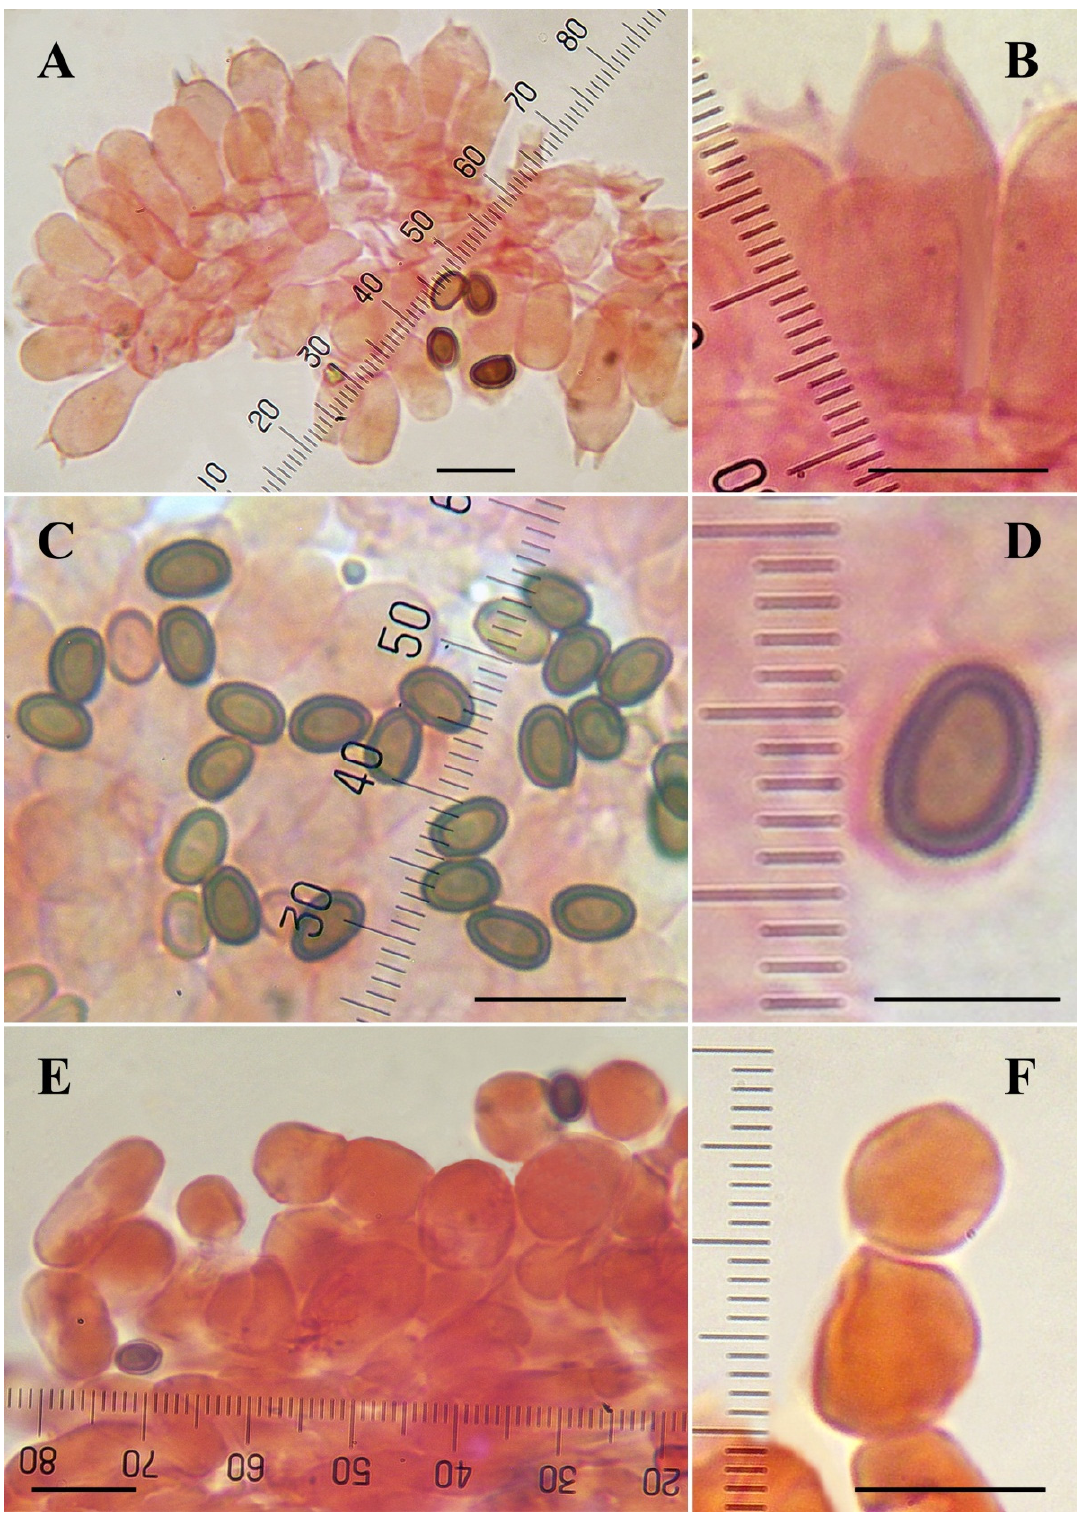
Figure 9. Microscopic characters of type specimen of Agaricus fiardii. ( A – F ) In ammonical Congo red (F353, K[M] 234316, holotype). ( A , B ) Basidia; ( C , D ) Spores; ( E , F ) Cheilocystidia. ( A – C,E , F ) Bar = 10 μ m; ( D ) Bar = 5 μ m. Photos by L.A. Parra.